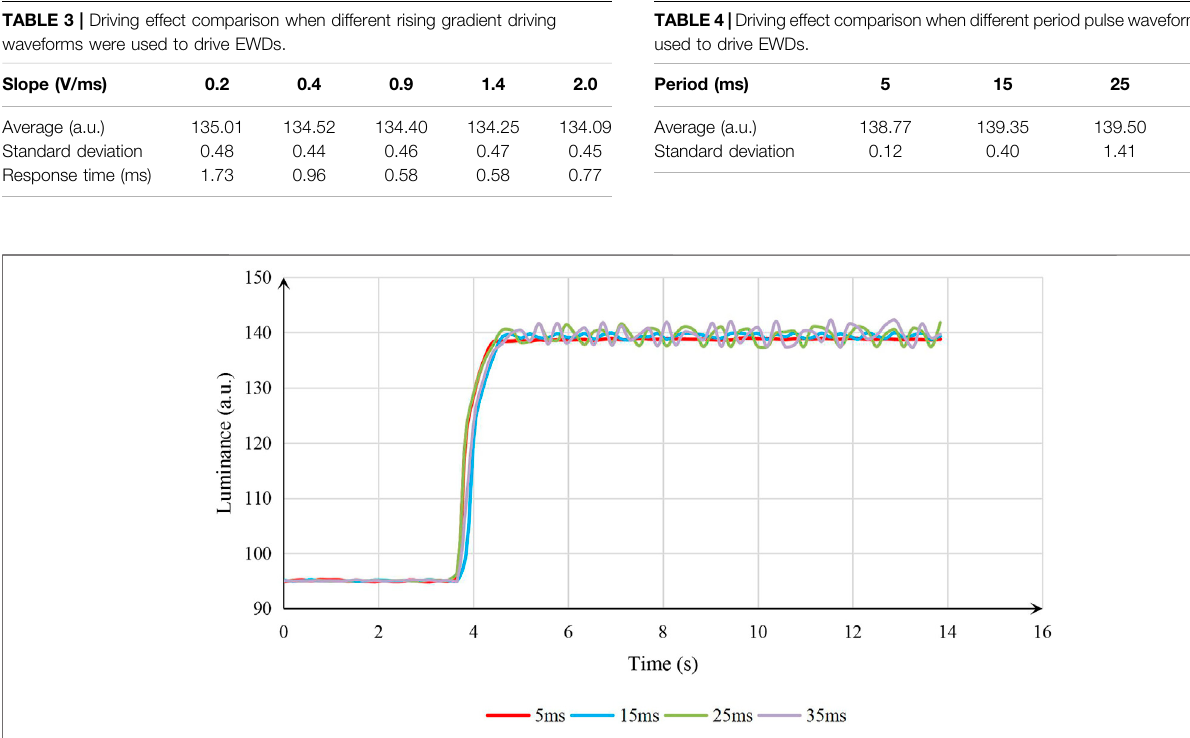
FIGURE10| ThebrightnesscurveofanEWDdrivenbyrisinggradientpulsewaveformatdifferentperiods.Squarewaveformswithperiodsof5,15,25,and35 ms were applied to the EWD panel. The curve was relatively stable when the period was 5 ms.